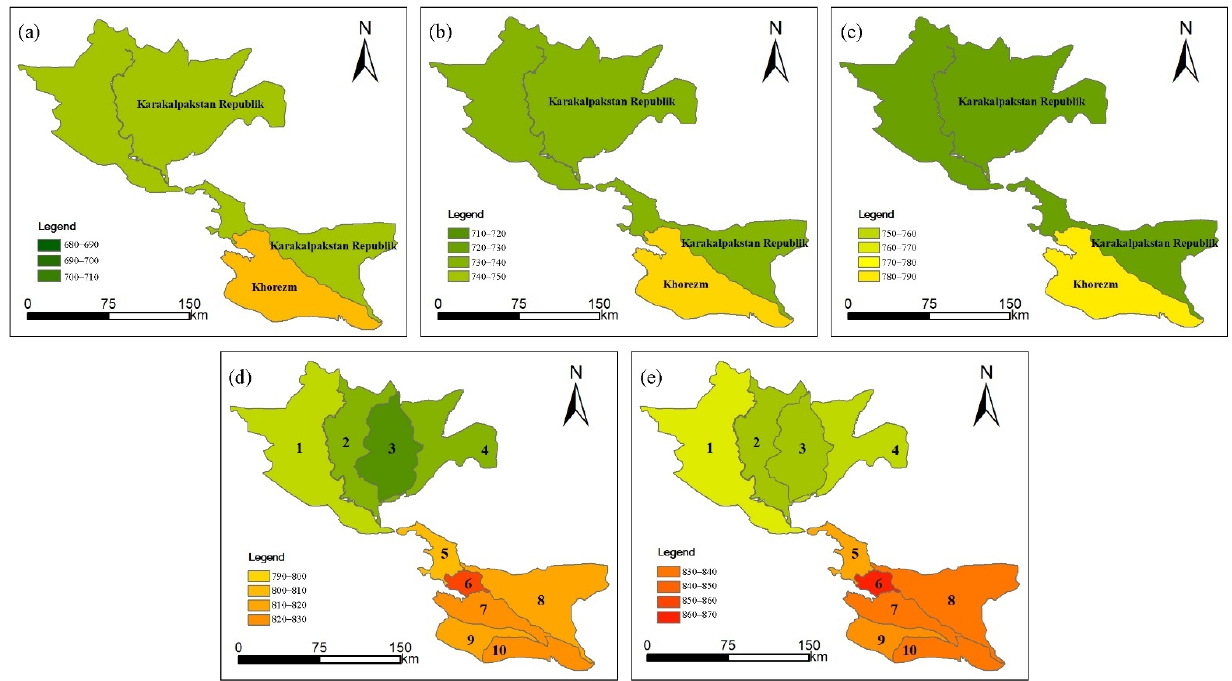
Figure 5. Variations of the CWRreg in the LADB in the past 50 years. (1970s ( a );1980s ( b ); 1990s ( c ); 2000s ( d ); 2010s ( e )). Results were displayed according to two zones before the 2000s, Karakalpakstan Republik and Khorezm; results were then displayed according to the new 10 UISs. 1 Suenli; 2 Kattagar-Bozatau; 3 Kizketken-Kegeyli; 4 Kuanishjarma; 5 Mangit-Nazarkhan; 6 Koramazi-Kilichniyozboy; 7 Shovot-Kulovot; 8 Pakhtaarna-Nayman; 9 Polvon-Gazavot; 10 Toshsoka. Peff was calculated for all crops ranging from 2.41 mm to 185.91 mm; the average Peff of wheat was the highest, which was 106.94 mm; and the average Peff of melon and vegetable was the lowest, which were 19.18 mm and 22.16 mm, respectively (Figure 6a). Combined with CWR and Peff, it can be known that the NIR of wheat and melon was the lowest, which are 501.37 mm and 517.67 mm, respectively, while the NIR was highest for rice and corn, which were 908.64 mm and 804.89 mm, respectively (Figure 6b). Combined with the CPP of each UISs, the NIRreg (Figure 6c) and IWRreg (Figure 6d) were calculated. The UIS named Suenli has the highest average IWRreg of 20.70 × 10 8 m 3 . The Koramazi- Killchniyozboy had the lowest average IWRreg of 2.88 × 10 8 m 3 . From Table 4 and Figure 6d, with the increase of cultivated land area, the IWRreg also shows an increasing trend, and there is a good consistency between cultivated land area and IWR.